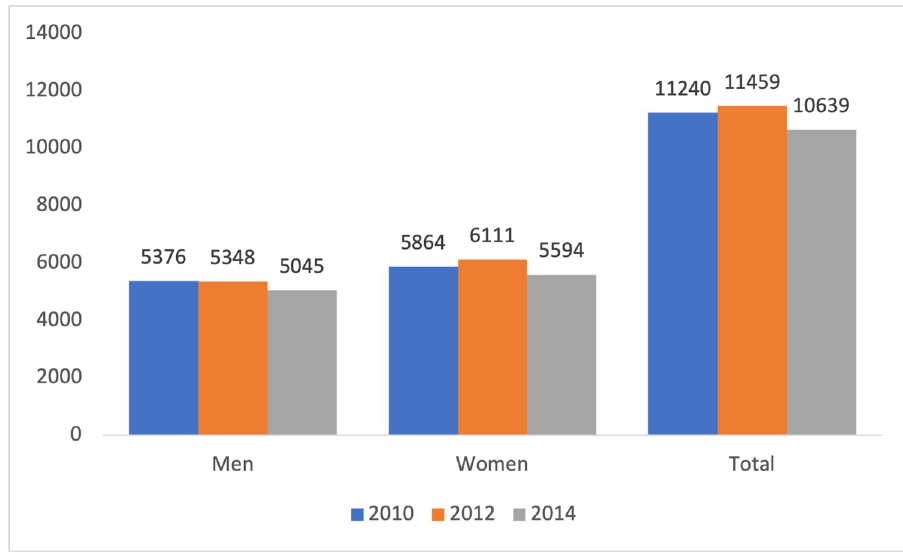
Fig 1. Ph.D. students by